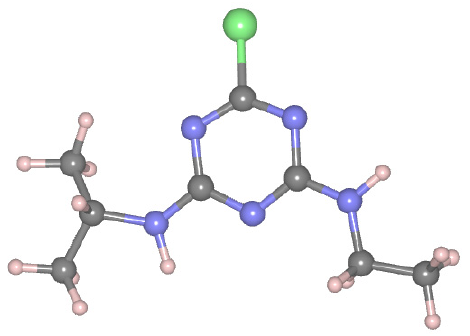
Scheme 1. Atrazine